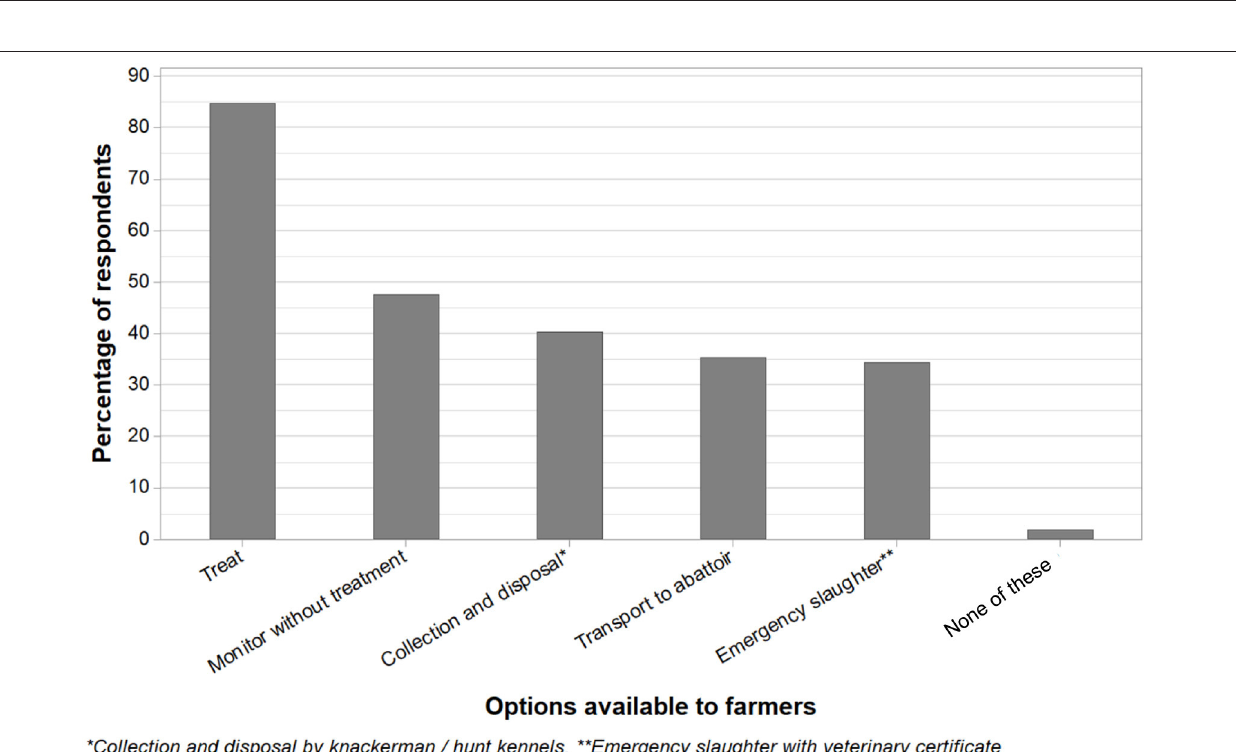
Frontiers in Veterinary Science | www.frontiersin.org